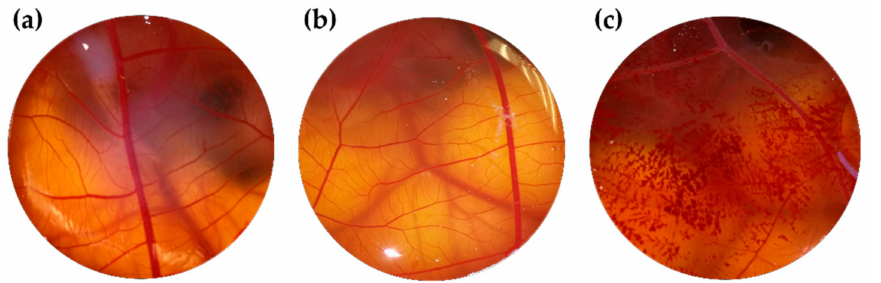
Figure 6. HET-CAM test assessed with different formulations: ( a ) bLF-LIP; ( b ) free bLF and ( c ) positive control. Table 5. Ocular tolerance: in vitro (HET-CAM) and in vivo (Draize test).